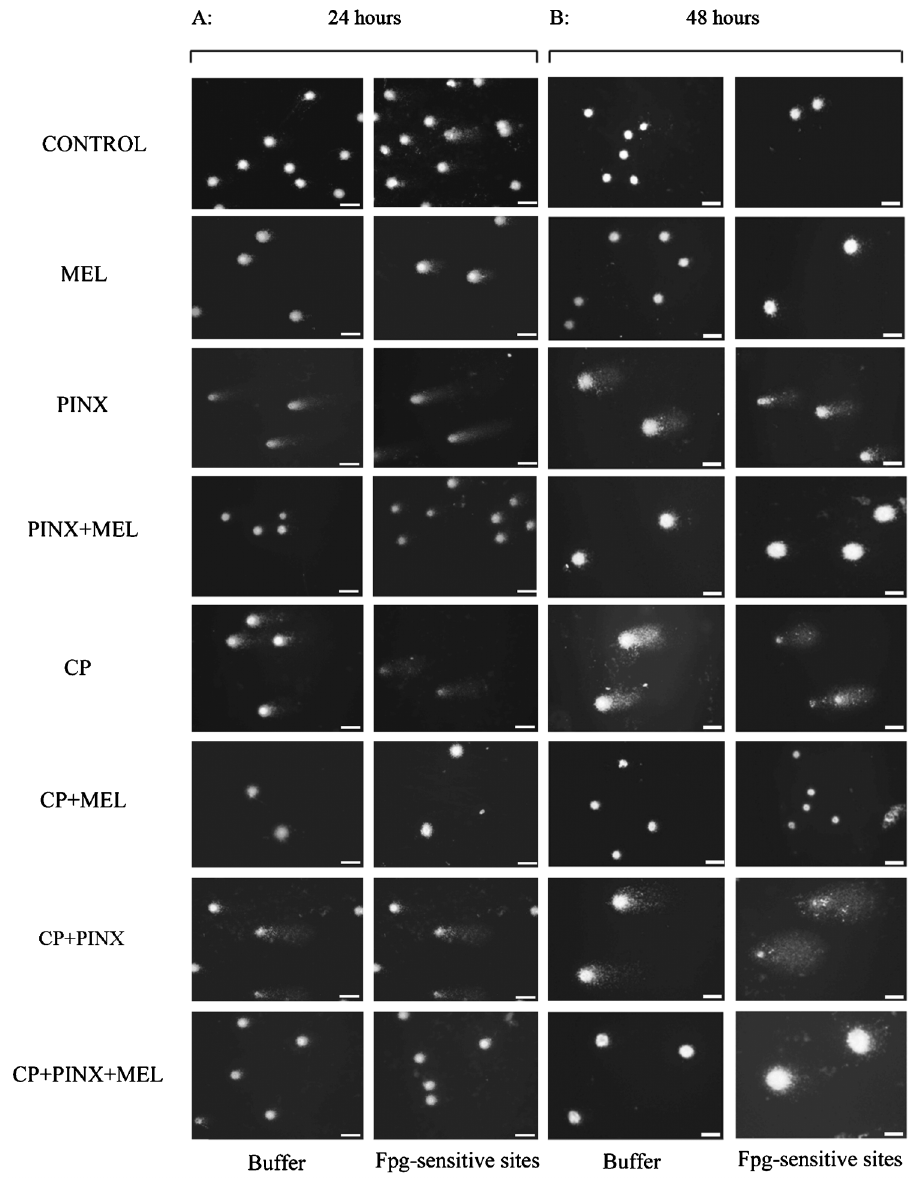
Figure 1. A , Images of formamidopyrimidine DNA glycosylase enzyme (Fpg)-sensitive sites determined by the Fpg-comet assay 24 h after treatment with 50 mg/kg cyclophosphamide (CP). MEL = melatonin; PINX = pinealectomized animals. B , Images of Fpg- sensitive sites determined by the Fpg-comet assay 48 h after treatment with 50 mg/kg CP. n = 5 animals per